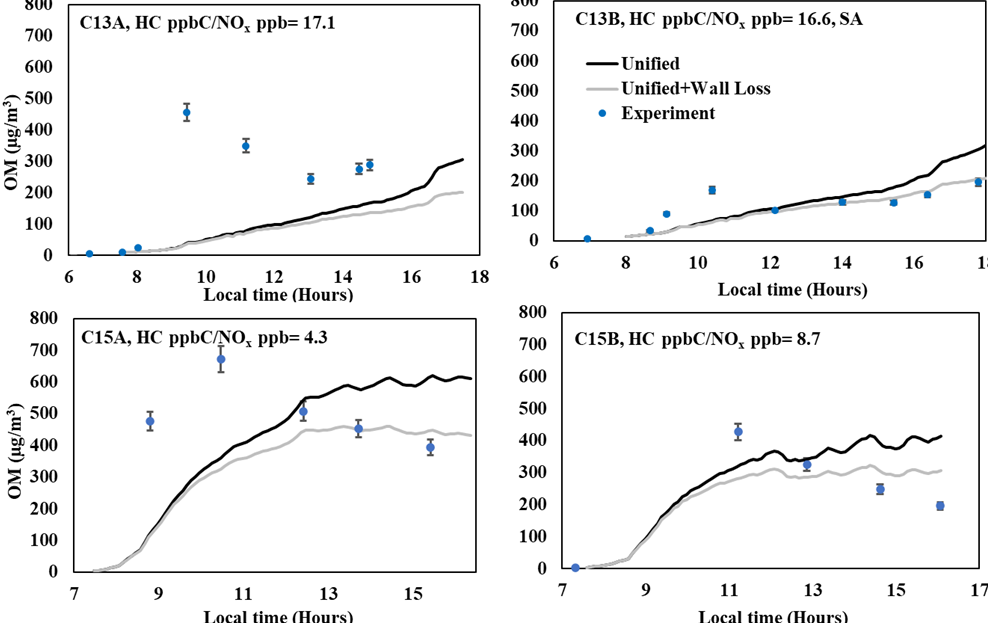
Figure 5. Comparison of the observed and predicted SOA mass produced from the photooxidation of C13 and C15 alkanes under different experimental conditions. The SOA simulation was performed by using the unified product distributions constructed with the IVC approach in the presence of precursor vapor deposition to the chamber wall. In addition, SOA simulation was performed in the presence (gray line) and absence (black line) of organic product loss to the wall. The observed SOA mass (dots) was corrected for gas dilution and the particle loss to the chamber wall. ASCM was used to measure SOA mass concentrations for C13 and C15 instead of OC/EC data as the artifacts via off-gassing of semi-volatiles to the denuder upstream of OC for C13 and C15 oxidation products. The collection efficiency of organic alkane aerosol for the ACSM was assumed to be 66% for C13 and 63% for C15. The collection efficiency was determined by comparison of SMPS data with ACSM data, with the aerosol originating from non-volatile organics. The collection efficiency of C13B aerosol, which was produced in the presence of acidic seed, was assumed to be 100%. The error associated with OM (6%) is calculated with ACSM data.